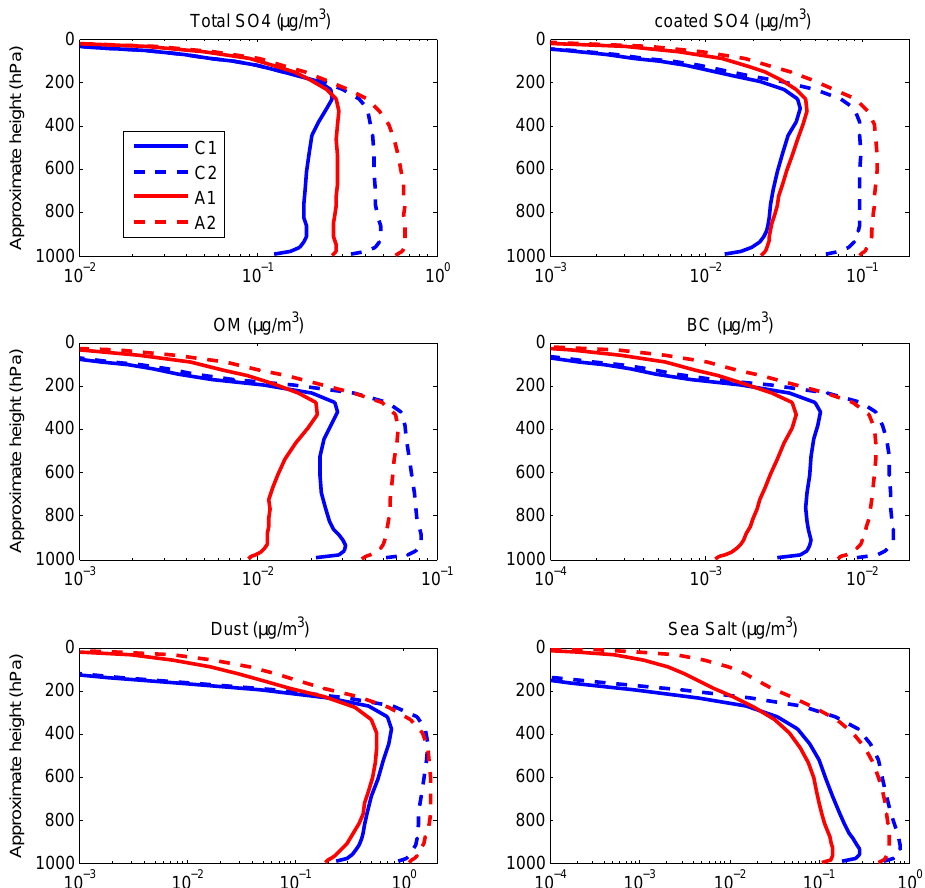
Fig. 9. Annual mean vertical profiles of sulfate, coated sulfate OM, BC, dust and sea salt in the North Polar region ( > 80 ◦ N) from C1, C2, A1 and A2. Table 8. Aerosol optical